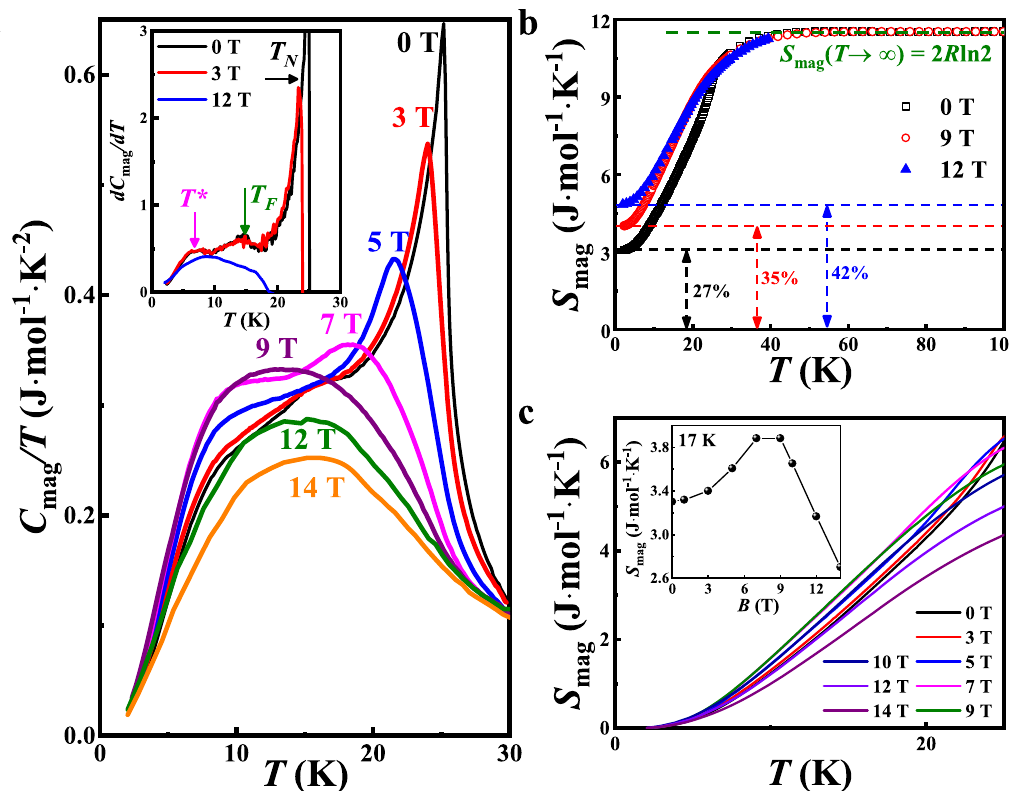
Fig. 1 Heat capacity of Na 2 Co 2 TeO 6 . a Temperature dependence of the magnetic speci fi c heat of NCTO for different magnetic fi elds up to 14 T. The inset shows the differential magnetic speci fi c heat dC mag / dT , and three transitions are observed as T N , T F , and T * , respectively. b The magnetic entropy S mag ( T ) at 0, 9, and 12 T. The olive dashed line refers to S mag ( T → ∞ ) calculated with effective spin J eff = 1/2 for Co 2 + . In order to better observe the residual magnetic entropy, the S mag ( T ) curves are shifted vertically so that their maxima coincide with the S mag ( T → ∞ ). The black, red, and blue dashed line refer to the possible residual magnetic entropy below 2 K under different magnetic fi eld. Compared with the total magnetic entropy S mag ( T → ∞ ), the percentage of residual magnetic entropy in different magnetic fi elds is shown in the fi gure. c A zoom-in of magnetic entropy below T N at various magnetic fi elds. Note the data are not shifted vertically as opposed to ( b ). The inset shows the fi eld dependence of the S mag at 17